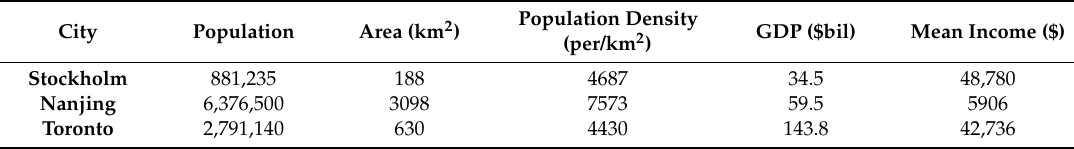
Table 1. Basic statistics of three cities in